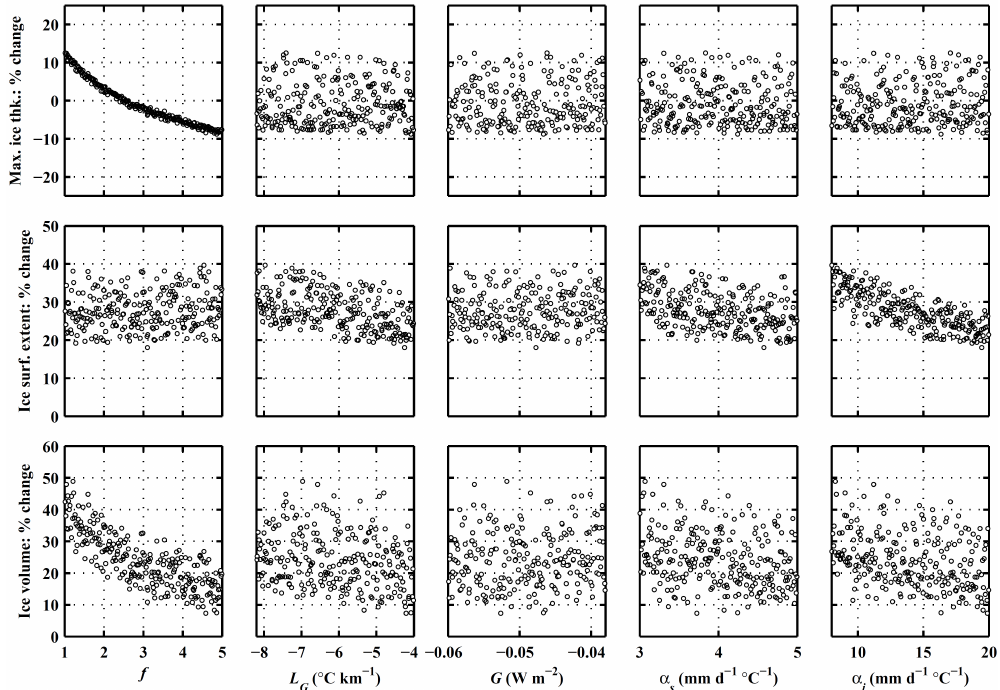
Figure 7. Sensitivity of three diagnostics describing the response of ice-sheet geometry (ice volume, ice surface extent and maximum ice thickness) to different values of the enhancement flow factor ( f ), the atmospheric lapse rate ( L G ), the geothermal heat flux ( G ) and the ice ( α i ) and snow ( α s ) PDD factors for the calculation of ablation. All values correspond to the end of the simulation at 50000 years where equilibrium is reached and are relative to observations derived from the Bamber dataset.